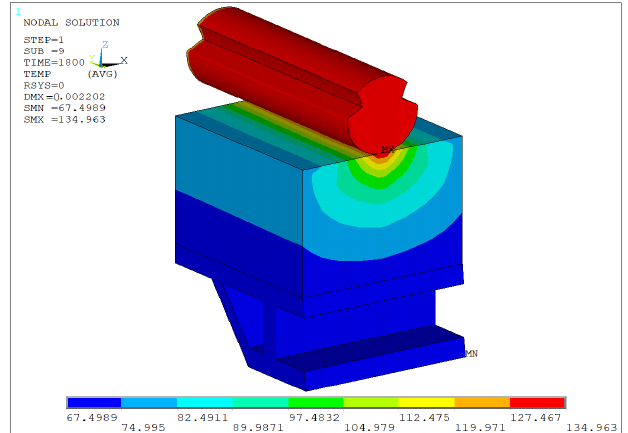
Figure 8. Temperature field in the cross-section of the composite contact strip and the aluminum reinforcing bar.